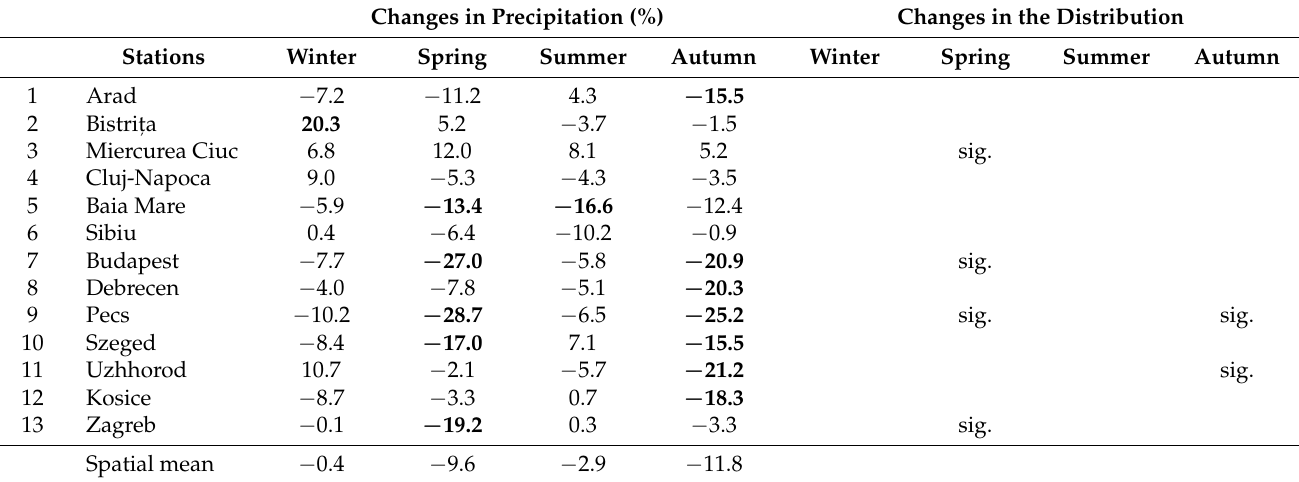
Table 5. Changes in precipitation in % (left) and changes in the probability distribution of precipitation (right) between historical (1871–1918) and current (1971–2020) periods in the Carpathian Region. Bold values and sig. indicate significant changes at the 0.05 significance level. Changes in the Distribution